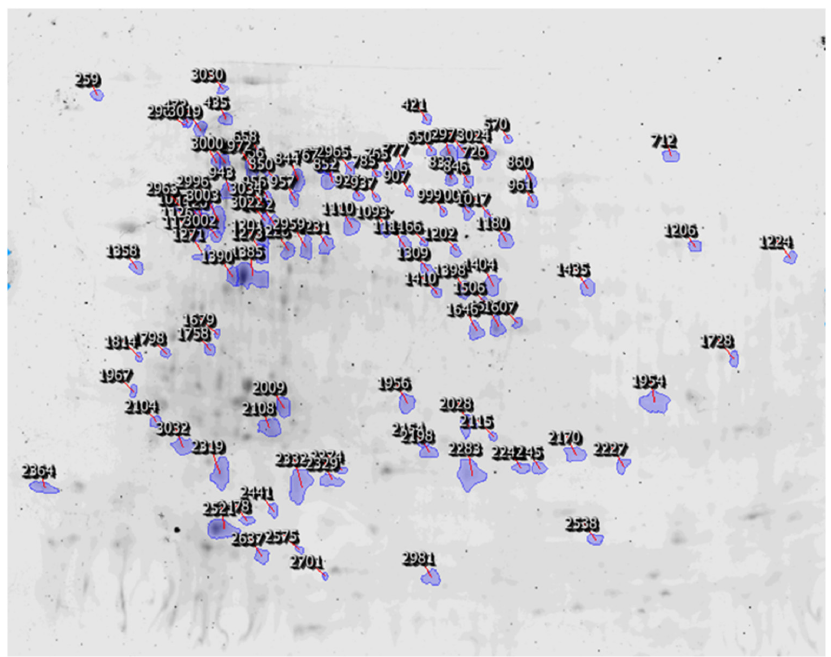
Figure 4. The 2D − DIGE gel separations of proteins from the STY geographic population and HDZ geographic population of Sitobion miscanthi .